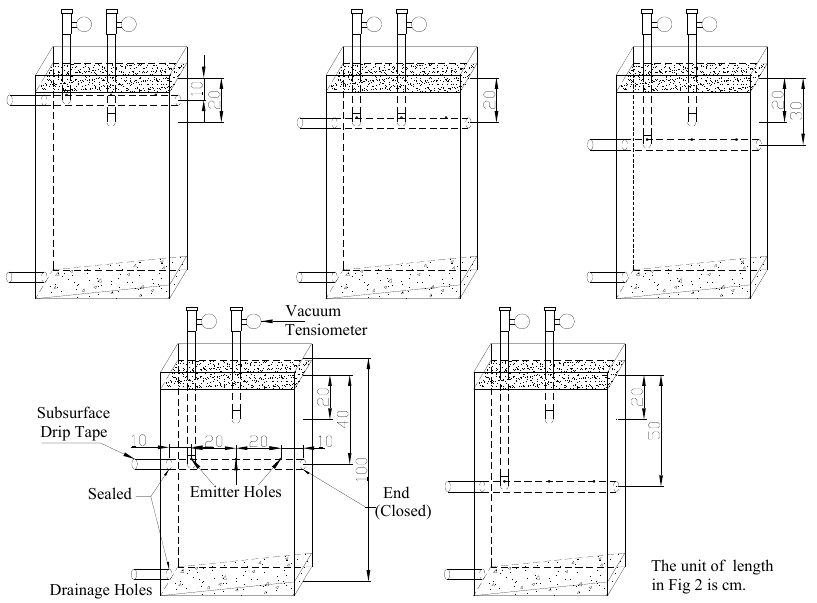
Figure 2. The layout of drip tape and tensiometers.